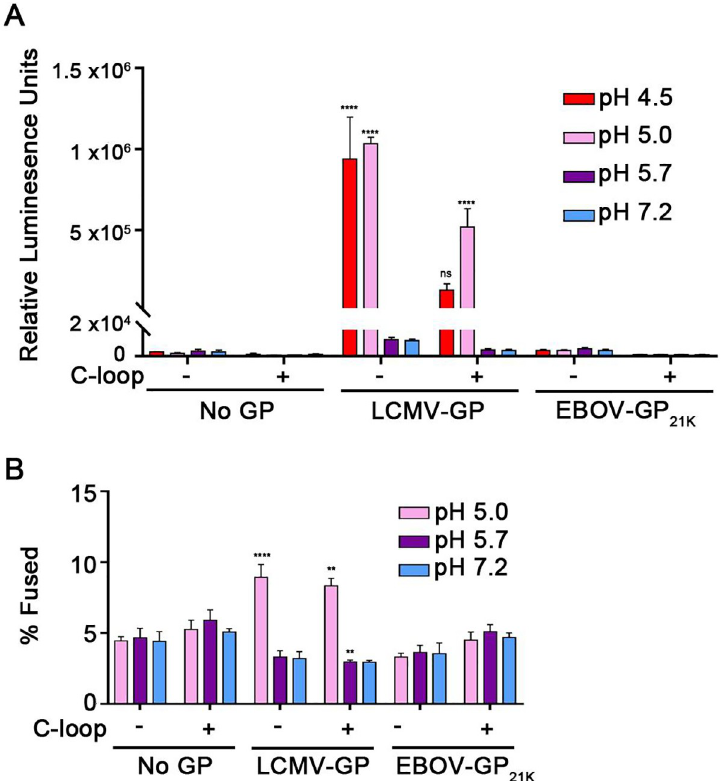
Fig 1. NPC1-C-loop and low pH and are not sufficient to trigger detectable cell-cell fusion (CCF) activity of